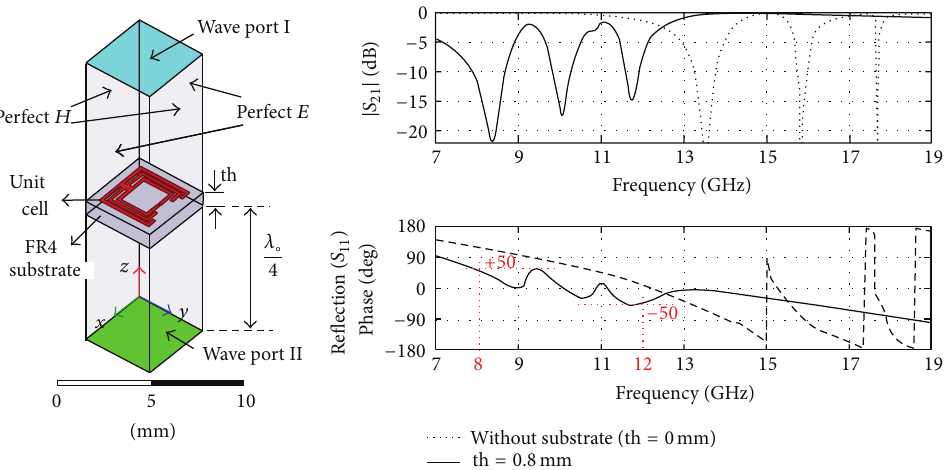
Figure 3: Reflected-wave unit-cell box study setup and the related results, S 21 and the phase (S 11 ).